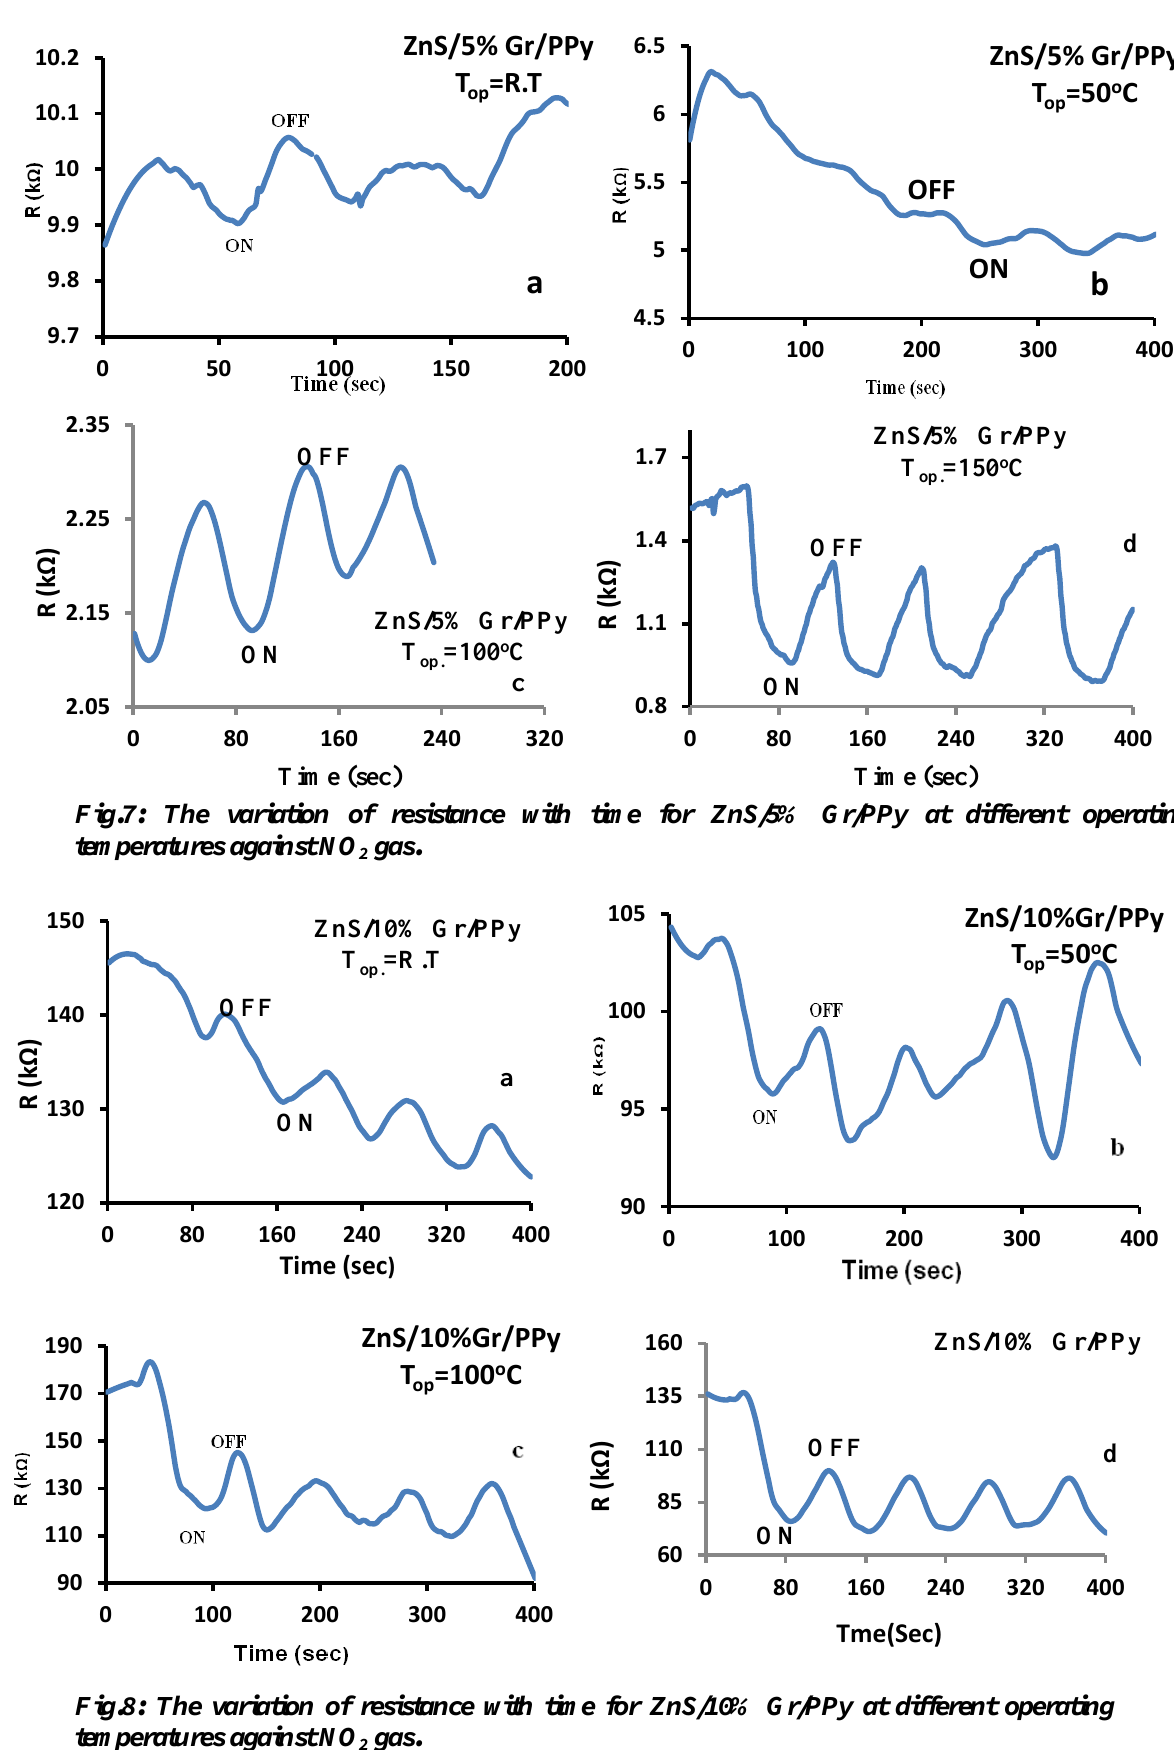
Fig.8: The variation of resistance with time for ZnS/10% Gr/PPy at different operating temperatures against NO 2